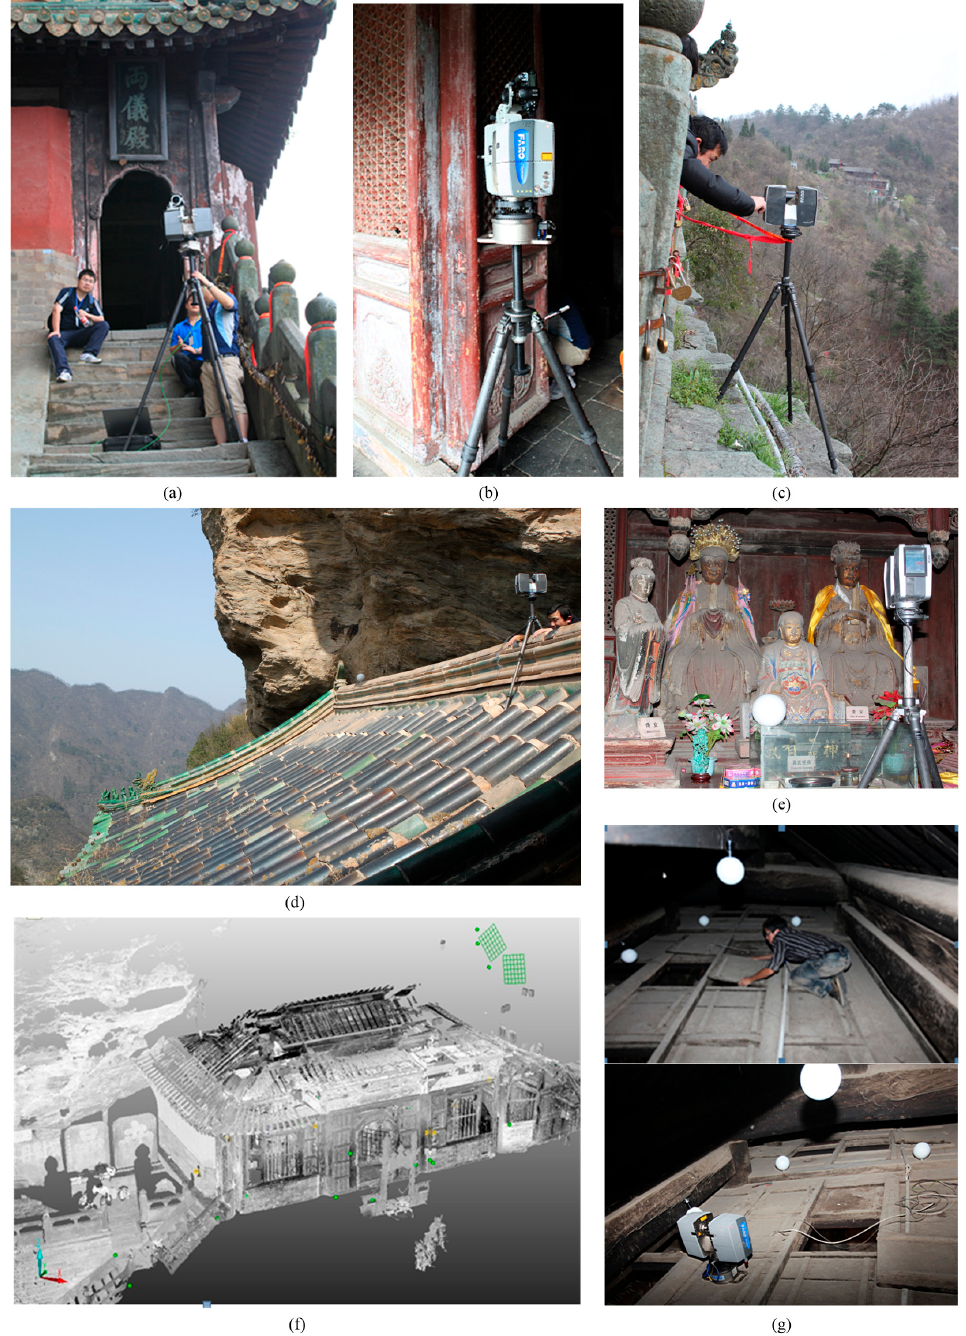
Figure 6. 3D data collection for the building. ( a ) Scanning for the gate; ( b ) scanning for the corridor; ( c ) scanning for the Longtou Incense; ( d ) scanning for the roof; ( e ) scanning for the statues; ( f ) point cloud of the whole building; ( g ) scanning for the attic.